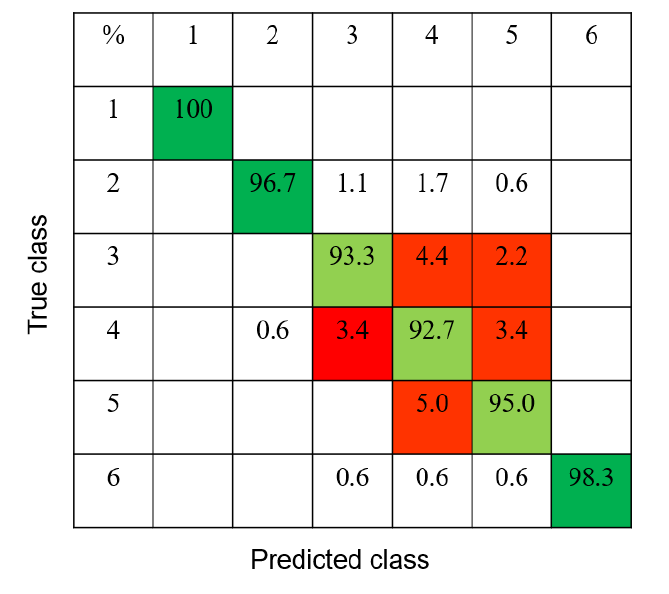
Figure 14. Classification accuracy evolution with SFS applied to SVM cubic model.